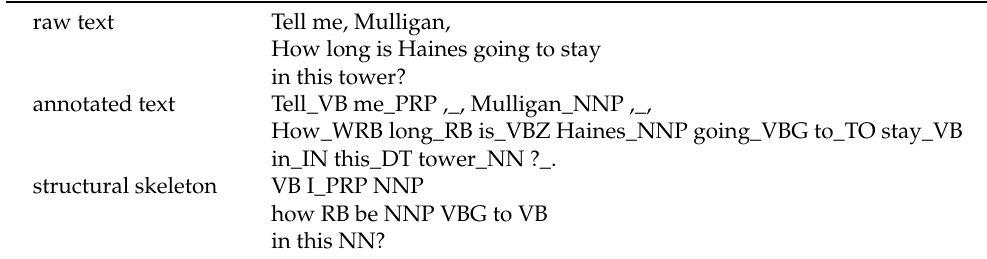
Table 1. From raw text to a structural skeleton. raw